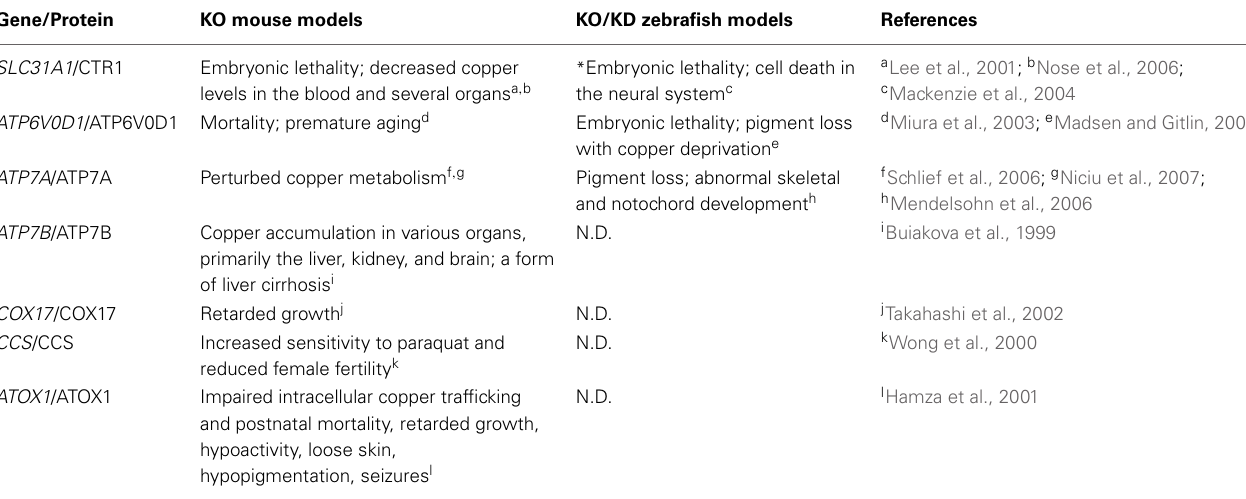
Table 6 | Copper metabolism–related mouse and zebrafish knockout/knockdown models and their phenotypes.